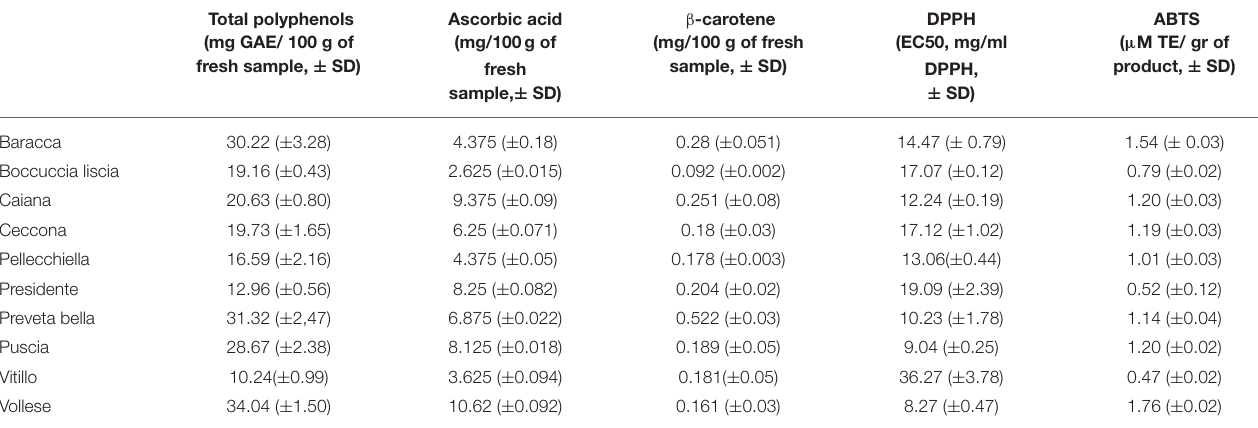
TABLE 1 | Total polyphenol content (TPs), ascorbic acid content, β -carotene content, and the antioxidant activity [assessed through the 2,2-diphenyl-1-picrylhydrazyl (DPPH), and 2, 20-azino-bis (3-ethylbenzothiazoline-6-sulfonic acid) (ABTS) tests] exhibited by the varieties of apricots. Total polyphenols (mg GAE/ 100 g of